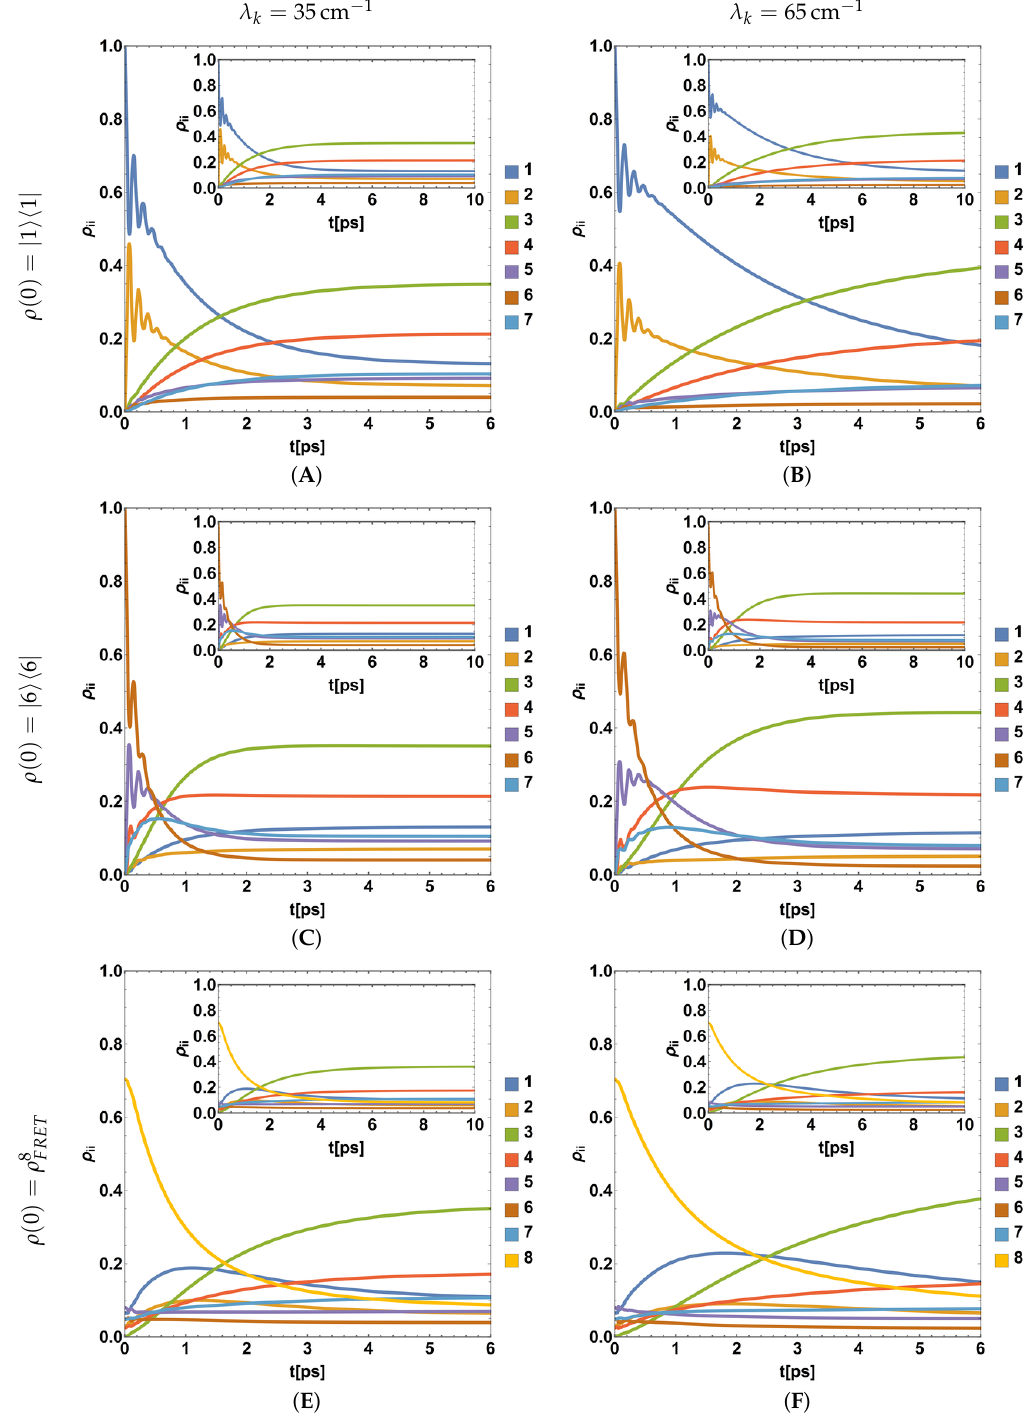
Figure 14. Population evolution in the first 6ps (10ps in the upper inset) for ( A – D ) N = 7 and ( E , F ) N = 8 BChls in the FMO monomer of C. tepidum with T = 293 ◦ K, γ k = 50cm − 1 . First and second columns for λ k = 35,65cm − 1 , respectively, and initial conditions: | 1 (cid:105)(cid:104) 1 | , | 6 (cid:105)(cid:104) 6 | and ρ 8 , FRET in rows. Note the differences in the coherence and transference times. ( A ) λ k = 35cm − 1 , ρ 0 = | 1 (cid:105)(cid:104) 1 | ; ( B ) λ k = 65cm − 1 , ρ 0 = | 1 (cid:105)(cid:104) 1 | ; ( C ) λ k = 35cm − 1 , ρ 0 = | 6 (cid:105)(cid:104) 6 | ; ( D ) λ k = 65cm − 1 , ρ 0 = | 6 (cid:105)(cid:104) 6 | ; ; ( F ) λ k = 65cm − 1 , ρ 0 = ρ 8 ( E ) λ k = 35cm − 1 , ρ 0 = ρ 8 FRET FRET